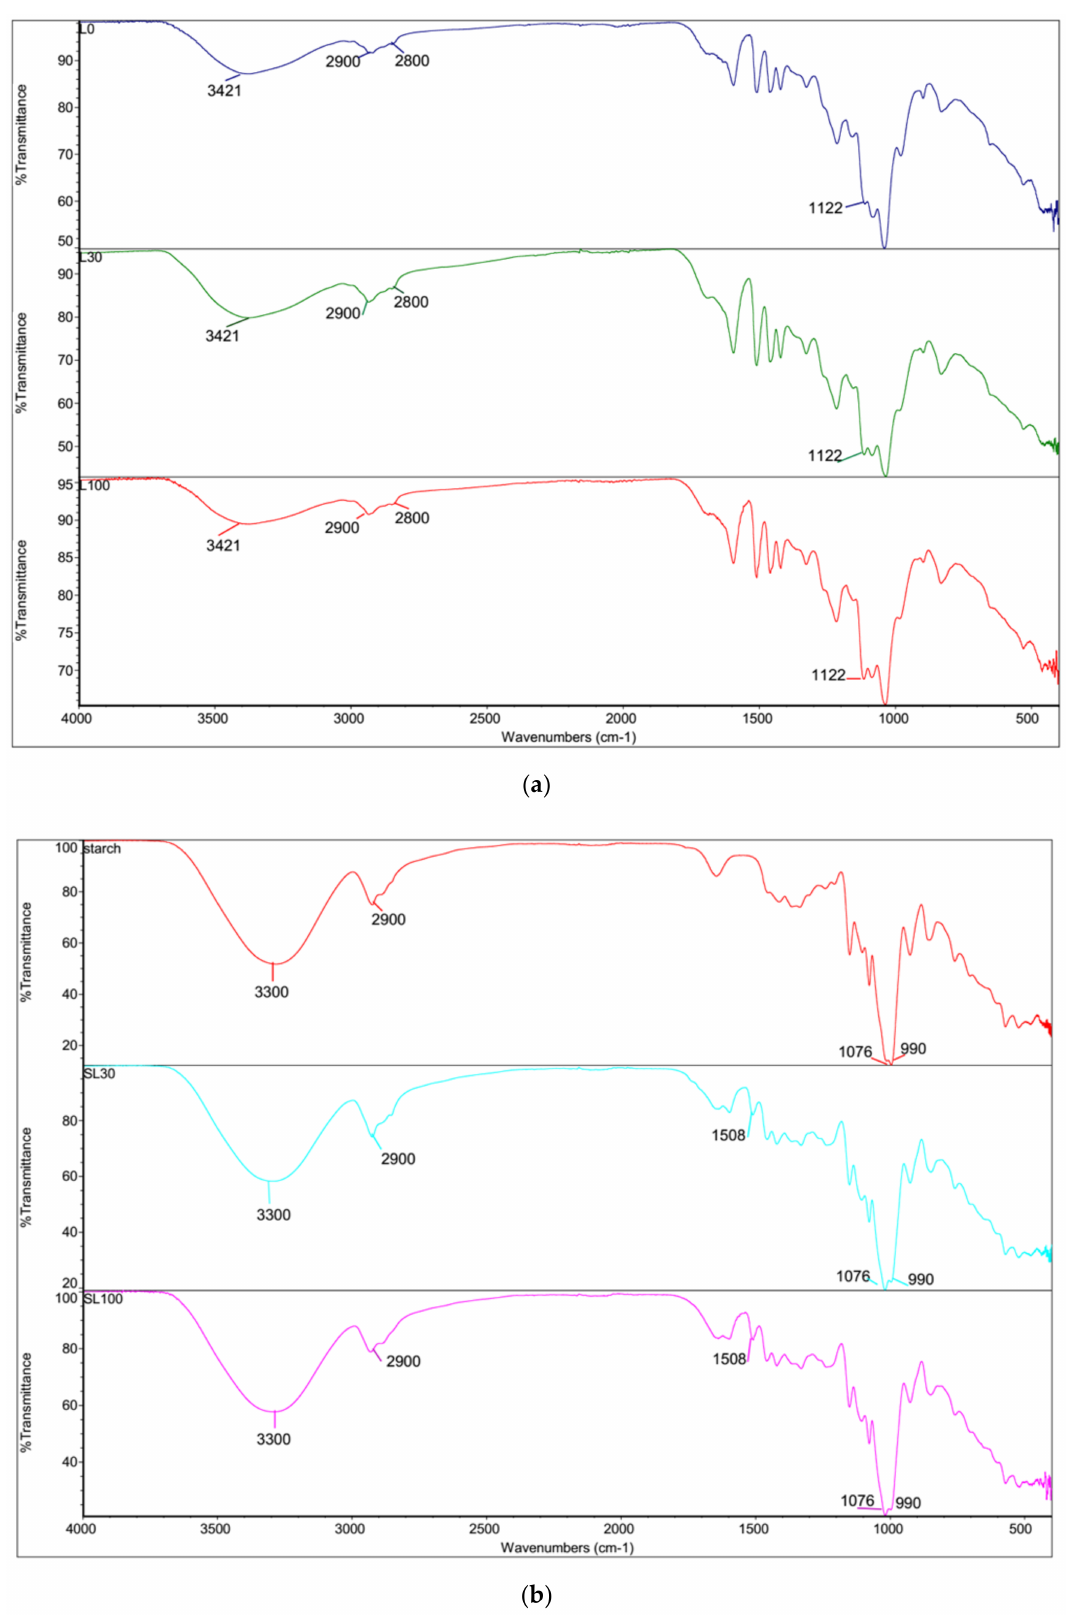
Figure 8. ( a ) Fourier-transform infrared spectroscopy of pure lignin before grinding (L) and after 30 and 100 grinding cycles (L30 and L100, respectively), ( b ) FTIR spectra of starch and lignin-starch composites containing ground lignin from the 30th and 100th grinding cycles (SL30 and SL100,